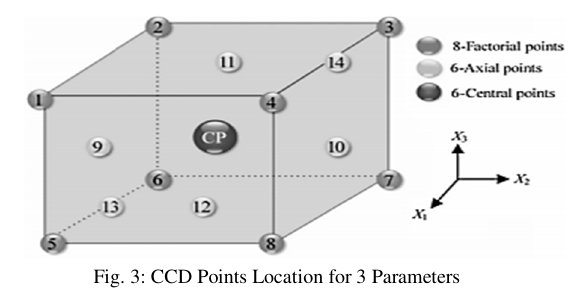
Fig. 3: CCD Points Location for 3 Parameters